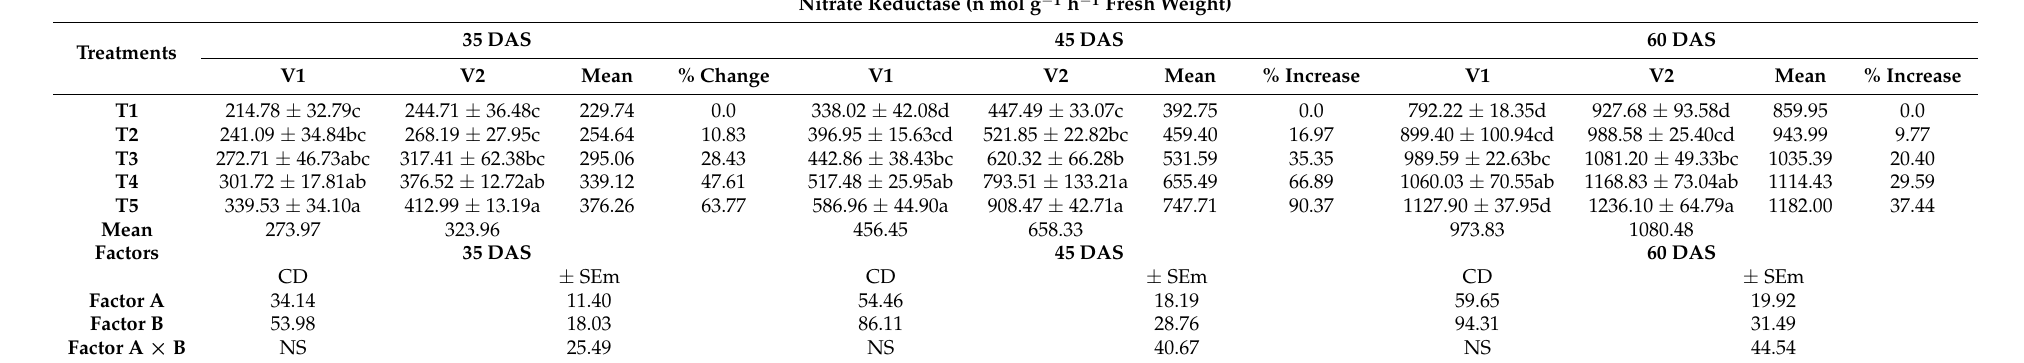
Table 6. Effect of hydro, Mg(NO 3 ) 2 , ZnSO 4 , Mg(NO 3 ) 2 + ZnSO 4 primed and nonprimed (control) seed treatments on nitrate reductase activity of leaves (n mol g − 1 h − 1 fresh weight) of wheat varieties, grown in the year 2017–2018.